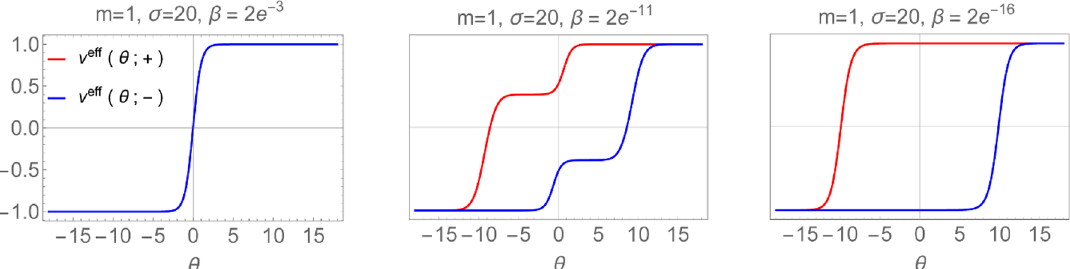
Figure 3 . E(cid:11)ective velocity pro(cid:12)les at equilibrium for three temperatures: for low temperatures (left (cid:12)gure) we observe the free fermion result, the group velocity tanh (cid:18) ; for intermediate temper- atures (middle (cid:12)gure) we observe the onset of the unstable particle; for high temperatures (right (cid:12)gure), where a new CFT is reached, e(cid:11)ective velocities of + ( (cid:0) ) particles are shifted so that they appear to be mostly right-moving (left-moving). The evolution of the e(cid:11)ective velocities as functions of temperature can be further explored in this video